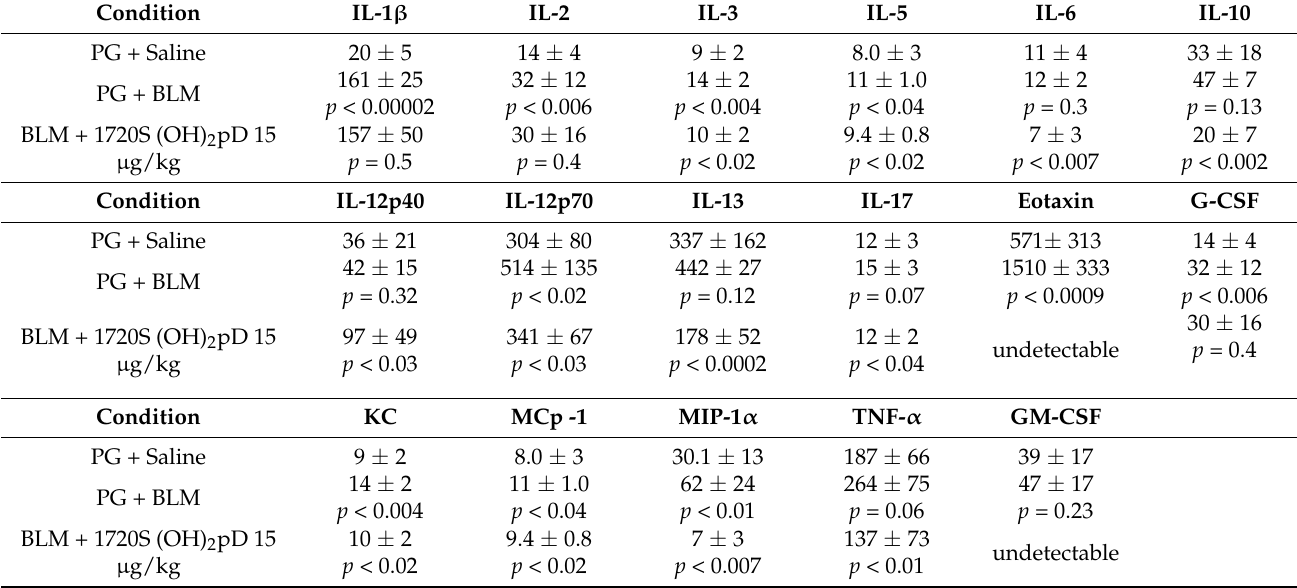
Table 1. 17,20S(OH) 2 pD modulates cytokines in the BLM model of skin